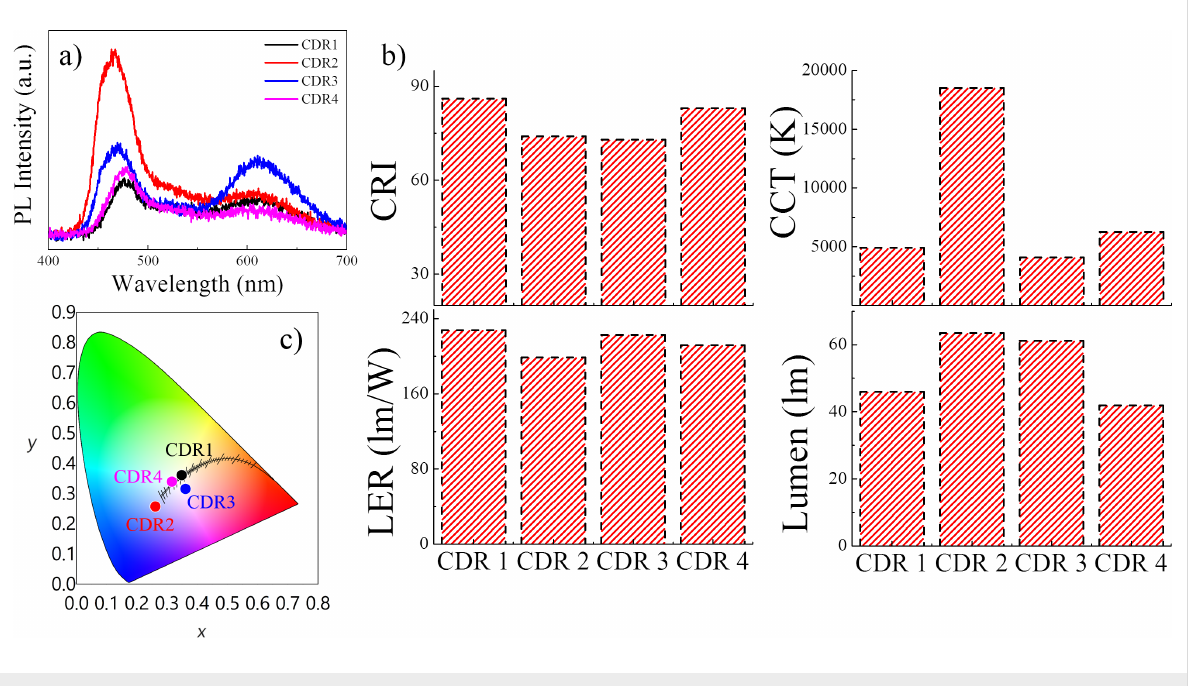
Figure 4: (a) The PL spectra of the WLED containing the drop-cast PVP/N-CDot films and inorganic red phosphor as color conversion layers over a 450 nm blue LED chip. The amounts of N-CDots and red phosphor within the composite films are varied. (b) The calculated CRI, CCT, LER and lumi- nous flux of the color conversion layers. (c) The CIE color coordinates of the white light generated by the color conversion